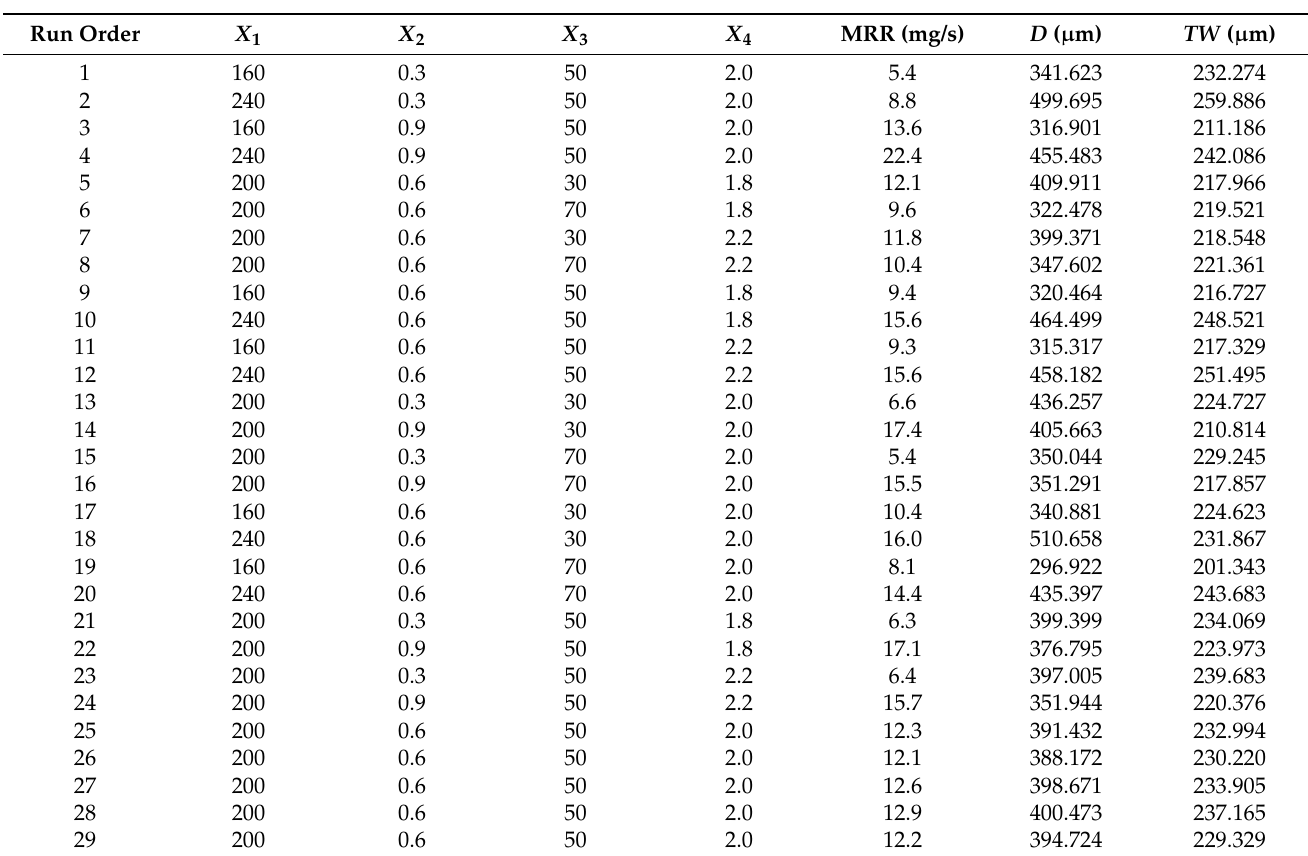
Table 6. Experimental design and results of the